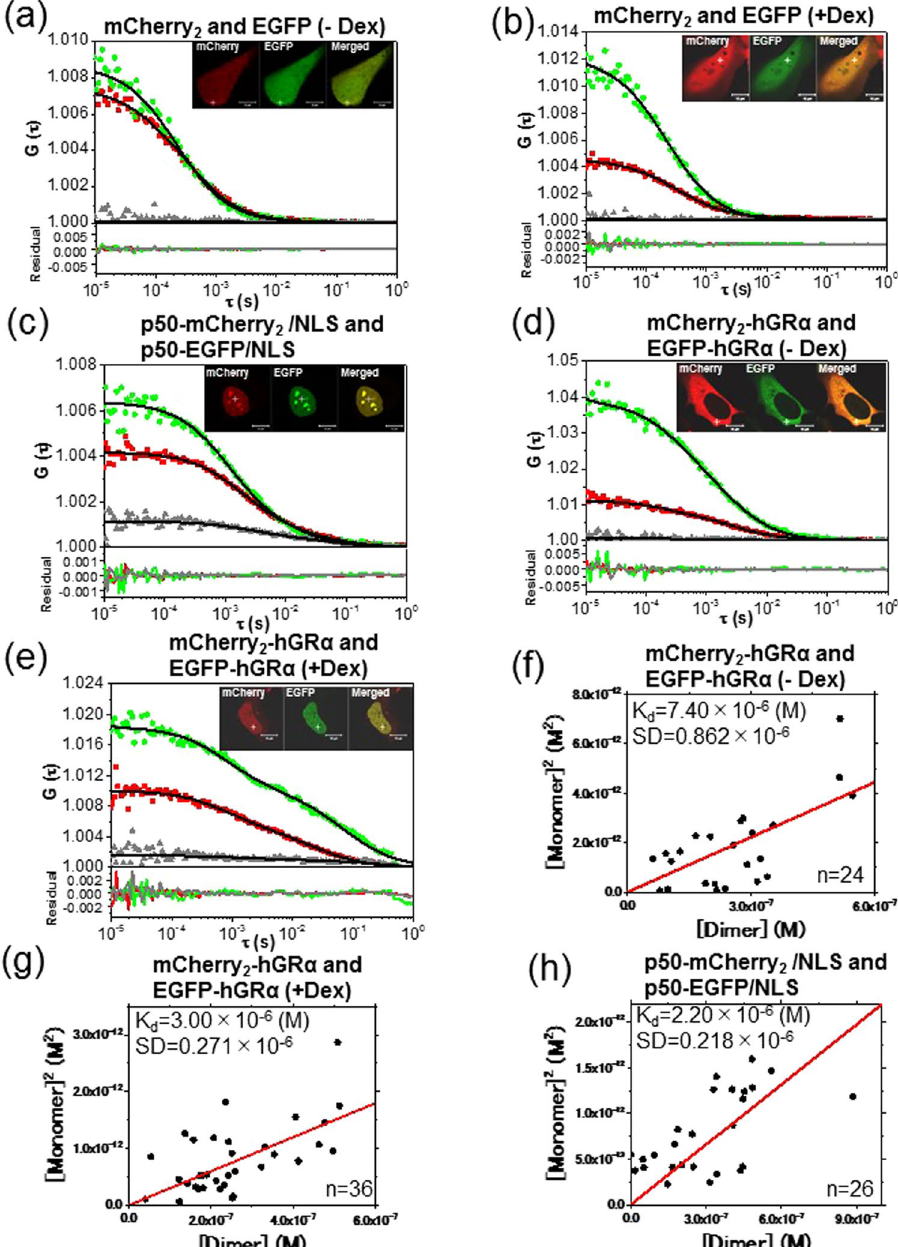
Figure 3. FCCS and K d analysis of mCherry 2 -GR α and EGFP-GR α . Typical auto- and cross-correlation curves constructed by measurements in U2OS cells coexpressing the pairs of chimeric fusion proteins before and after addition of the ligand. The filled green diamonds, red squares, and gray triangles denote the autocorrelation of the green channel [ G G ( τ )], autocorrelation of the red channel [ G R ( τ )], and the cross-correlation curve [ G C ( τ )], respectively, with their fits (solid black line) and residuals. The insets show LSM images of U2OS cells coexpressing the pairs of chimeric fusion proteins. Measurement positions of FCCS are indicated by the white crosshairs. The scale bars are 10 μ m. FCCS was performed in U2OS cells expressing mCherry 2 and EGFP as a negative control ( a ) before and ( b ) after addition of Dex, showing a flat cross-correlation amplitude. ( c ) A U2OS cell coexpressing p50-mCherry 2 /NLS and p50-EGFP/NLS as a positive control. ( d ) A U2OS cell coexpressing mCherry 2 /hGR α and EGFP/hGR α in the cytoplasm before addition of Dex. ( e ) A U2OS cell coexpressing mCherry 2 / hGR α and EGFP / hGR α in the nucleus 20 min after addition of 100 nM Dex. ( f , g , h ) Results of K d determination using a scatter plot and linear regression. The plots represent the square of the concentration of the monomeric hGR α versus the concentration of the dimer of hGR α . The solid lines show the linear fit. The slope indicates K d . ( f ) mCherry 2 -hGR α and EGFP-hGR α before addition of Dex. ( g ) mCherry 2 -hGR α and EGFP-hGR α after addition of Dex. ( h ) p50-mCherry 2 /NLS and